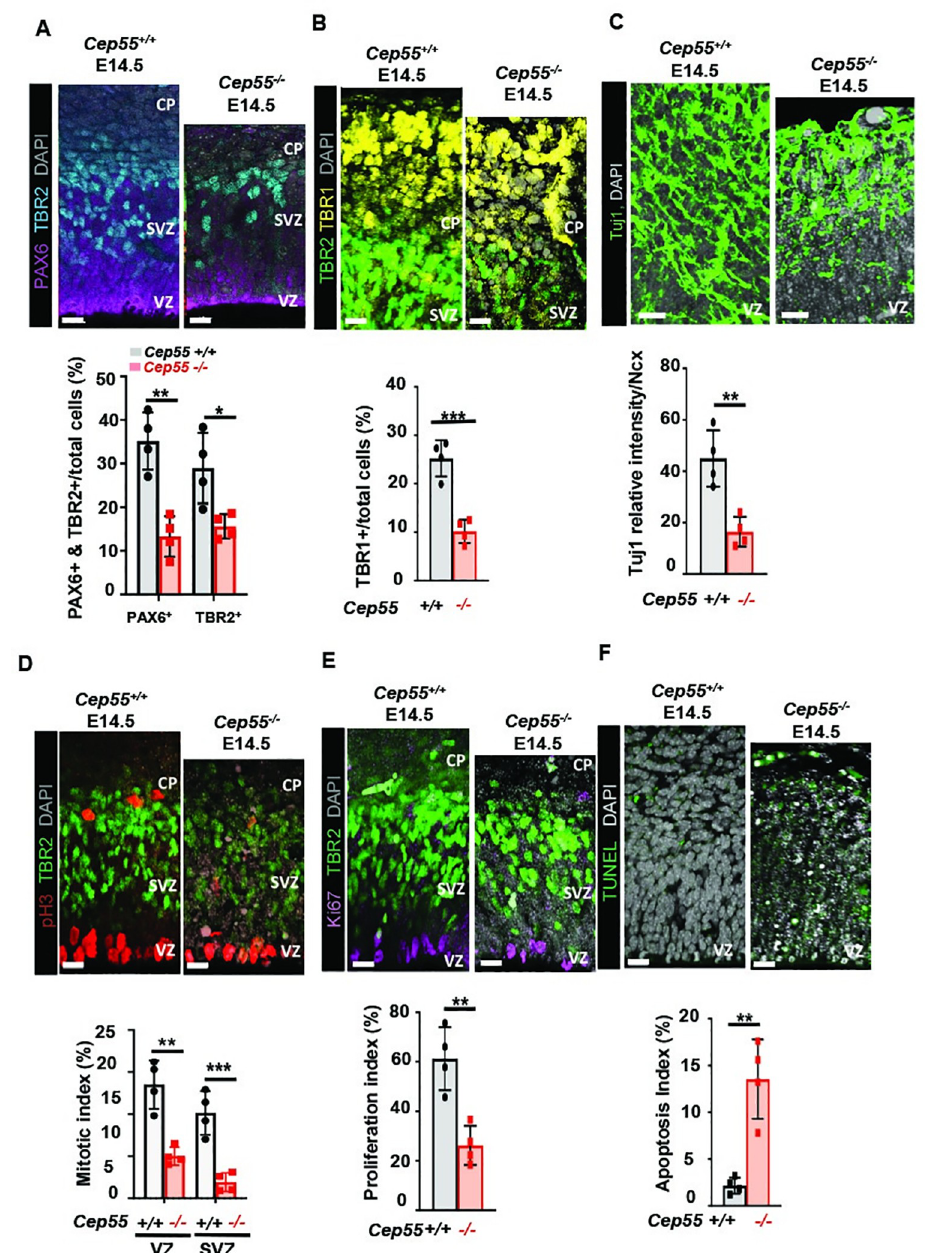
Fig 2. Cep55 regulates cell fate of radial glial and intermediate progenitor cells, and neurons. (A) Representative images of radial glial cells (RGC; Pax6+) at VZ, intermediate progenitor cells (IPC; Tbr2+) at SVZ and total cells (DAPI) at E14.5, scale = 15 μ m (upper panel). Quantification of percentage of RGCs (Pax6+, p < 0.0016) and IPCs (Tbr2+, p < 0.0337) in Cep55 +/+ and Cep55 -/- neocortices (Ncx) at E14.5 (lower). (B) Representative images of IPCs (Tbr2+) at SVZ, post-mitotic neurons (Tbr1+) at CP and total cells (DAPI, gray) at E14.5, scale = 15 μ m (upper), quantification of the percentage of post-mitotic-neurons (Tbr1+, p < 0.0005) in Cep55 +/+ and Cep55 -/- neocortices at E14.5 (lower). (C) Neuron-specific class III β -tubulin (Tuj1, p < 0.0037), relative intensity of Tuj1 staining quantified within a 100 μ m 2 field of view. (D) Phosphohistone H3 (pH3; mitotic cells) in the VZ and SVZ, co-stained with Tbr2 to identify proliferating IPCs at E14.5, scale = 15 μ m. Quantification of the percentage of total cells expressing pH3 to show the mitotic index in Vz, p < 0.0090; and SVZ, P < 0.0070. (E) Proliferating cells (Ki67+), IPCs (Tbr2+, green) delineating the SVZ, and total cells (DAPI) at E14.5, scale = 15 μ m (upper), Comparison of the proportion of Ki67 + cells in Cep55 +/+ and Cep55 -/- neocortices to show proliferation index (lower, p < 0.0034). (F) Apoptotic cells (TUNEL) and total cells (DAPI) in the Ncx, at E14.5, scale = 15 μ m (upper), comparison of proportion of apoptotic cells in Cep55 +/+ and Cep55 -/- neocortices to show apoptosis index (lower, p < 0.0019).